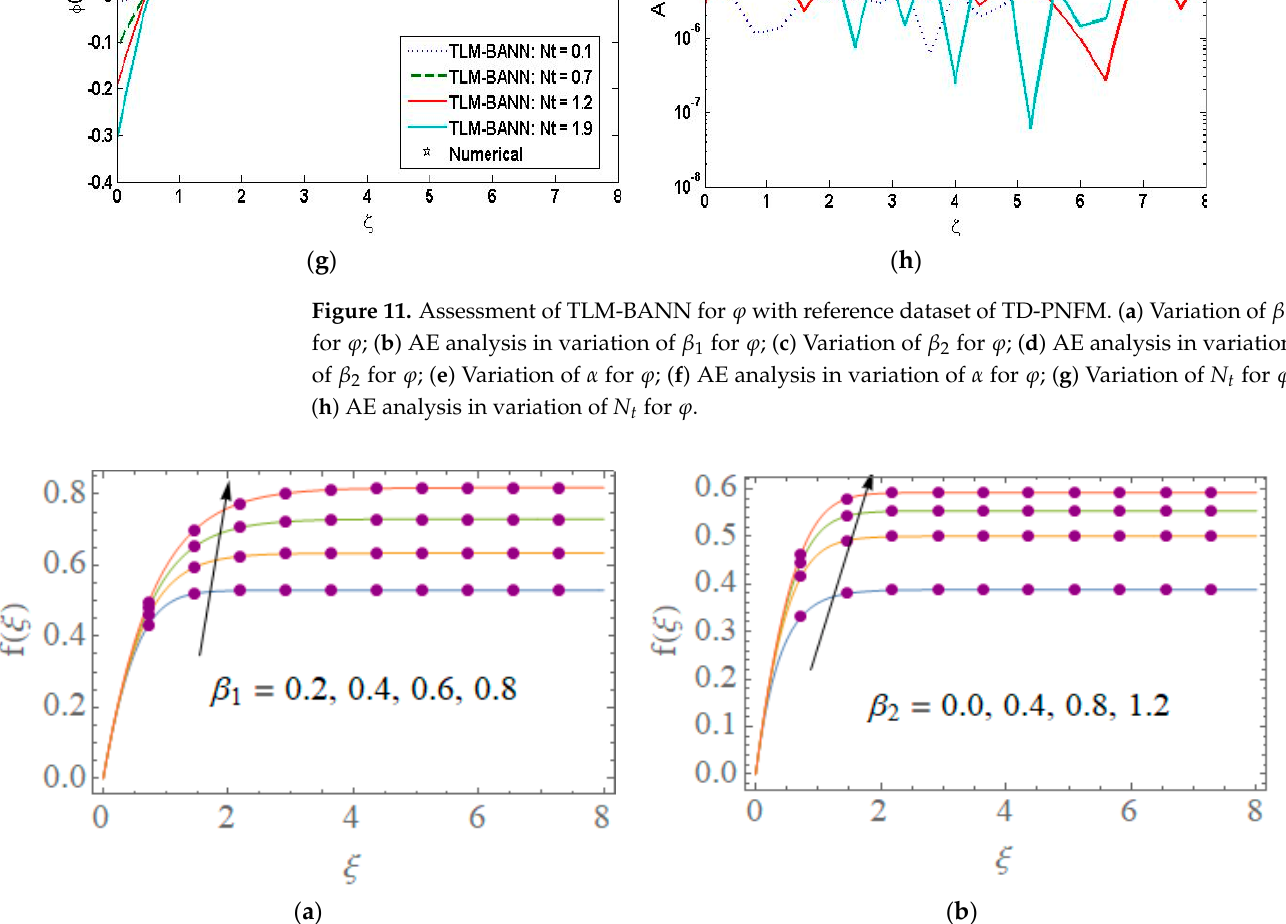
β for f ; ( b ) Variation of